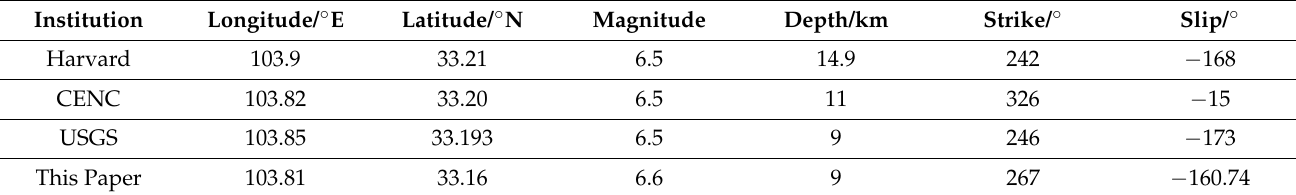
Figure 13. Fault slip distribution from InSAR inversions shown in 3D. Table 5. Earthquake mechanism from different earthquake